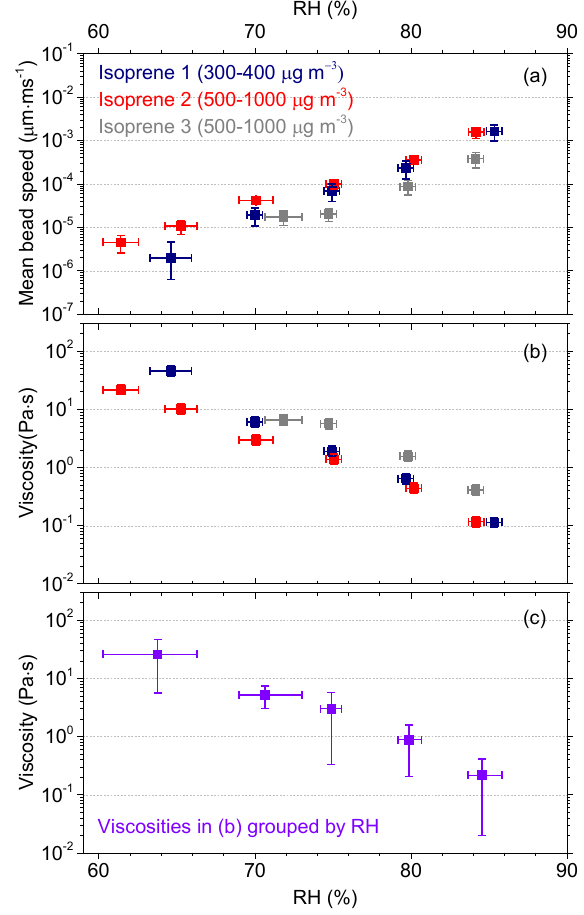
Figure 6. Results from bead-mobility experiments. (a) Mean bead speed of individual SOM samples (i.e., isoprene 1, 2, and 3). Table 1 lists the experimental conditions for each SOM sample. (b) Viscos- ity was determined from the mean bead speeds and a calibration line (Fig. 3). The x error bars in (a) and (b) represent the RH range in a given experiment and the uncertainty in RH measurements, and the y error bars represent 95% prediction intervals. (c) Mean viscosi- ties in (b) grouped by RH: three data points were included in each group. The y error bars represent 95% confidence intervals of vis- cosities in (b) grouped by RH and x error bars indicate the lowest and highest RH ranges in the group and the uncertainty in the RH